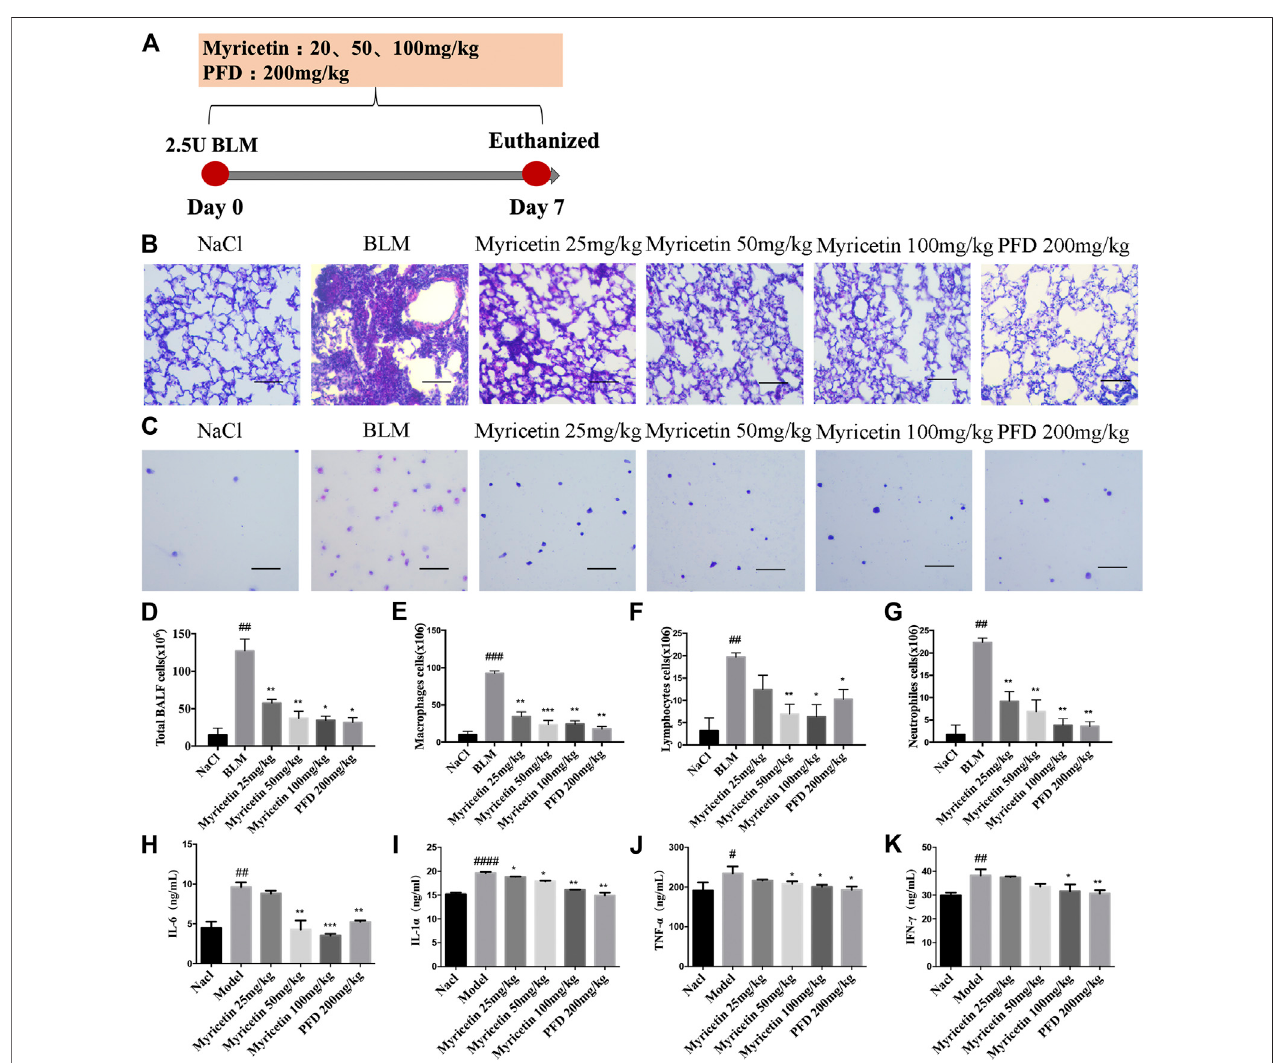
FIGURE3| Myricetinreducesthein fl ammatoryresponseinBLM-treatedmice. (A) DosingregimeninBLM-inducedin fl ammatorymodel. (B – C) H&Estainingofleft lung tissues (B, Scale: 50 μ m) and in fl ammatory cells in BALF (C, Scale: 20 μ m) of each group. (D) Total number of cells from BALF in each group. (E) Counts of macrophages in BALF. (F) Counts of lymphocytes in BALF. (G) Counts of Neutrophiles in BALF. (H – K) The expression of in fl ammatory factors including IL-6, IL-1 α , TNF- α and IFN- γ in BALF were detected by ELISA. Data are shown as mean ± SD. # represent the difference between NaCl and BLM-treated group, ## P < 0.01, ### P < 0.001, #### P < 0.0001. * represent the difference between BLM-treated and treatment group, * P < 0.05, ** P < 0.01, *** P < 0.001, **** P < 0.0001.